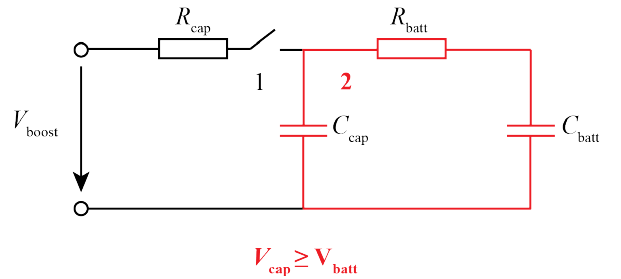
Kyle Retan: Simulative verification of a semi-active broadband energy harvester 5 Figure 6. Transition state of the battery charging circuit. Figure 6. Transition state of the battery charging circuit.